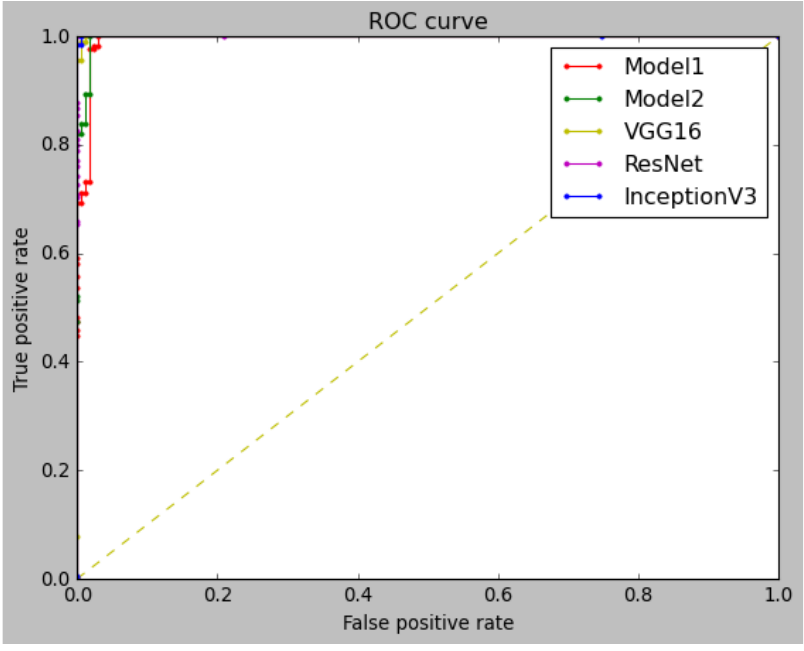
Figure 3. ROC curve of last fold cross-validation sample. (AUC for model 1- 0.994434, Model 2- 0.997247, VGG16-0.999671, ResNet50- 0.994859, and Inception V3- 0.999910).